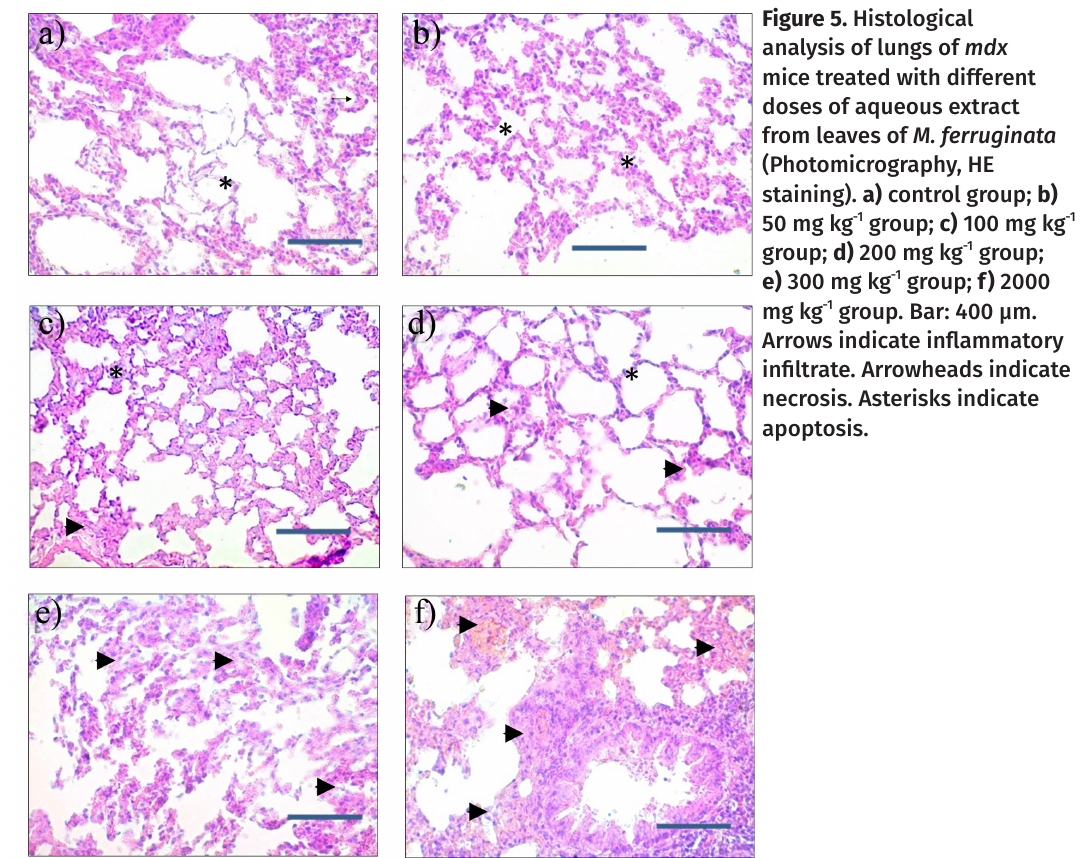
Figure 5. Histological analysis of lungs of mdx mice treated with different doses of aqueous extract from leaves of M. ferruginata (Photomicrography, HE